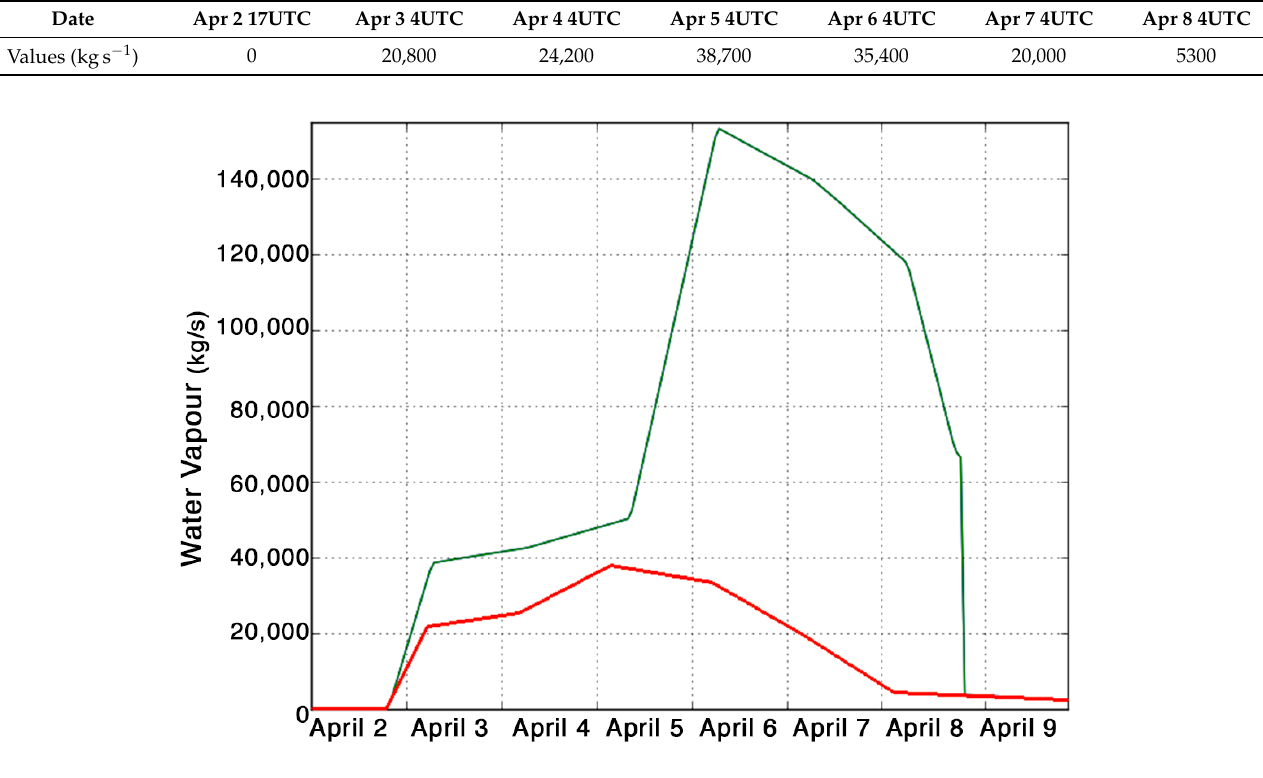
Figure 6. Evolution of the quantity of sea water evaporated between 2 and 9 April. The green curve corresponds to the dynamics of the theoretical quantity of water. In red, adjustments in this quantity obtained by a top-down approach to better represent injection heights consistent with the satellite